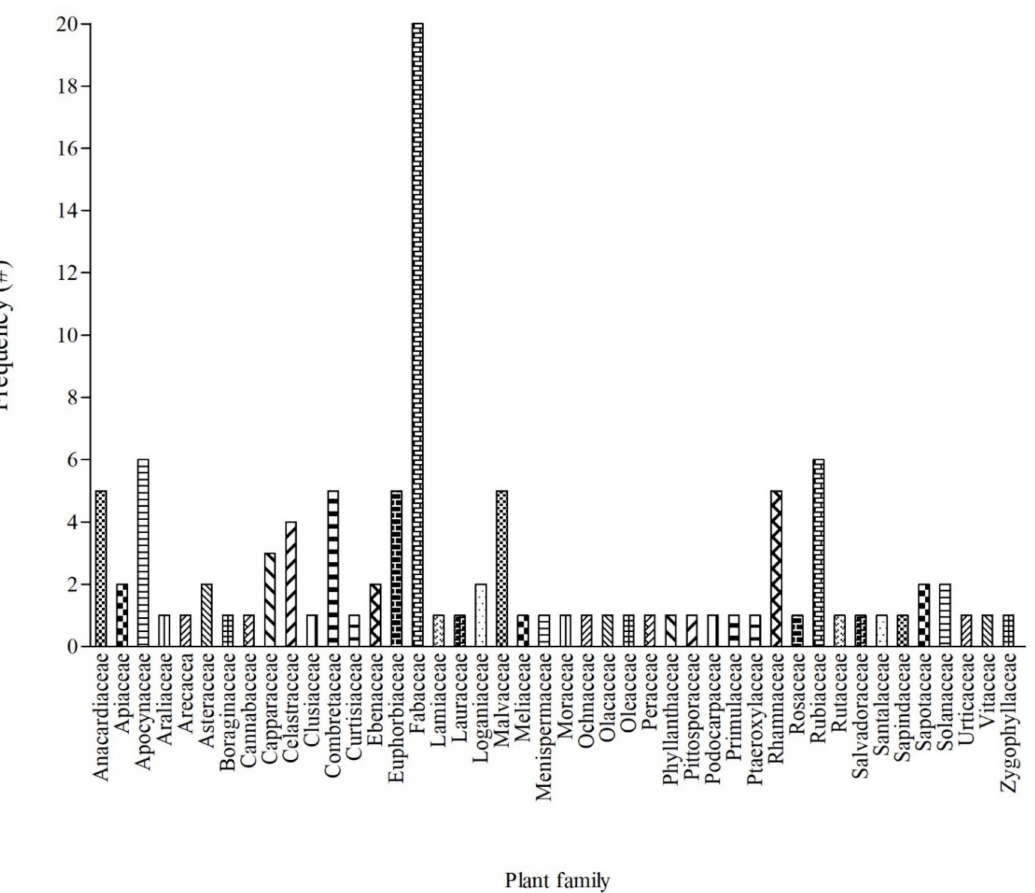
Figure 1. Frequency of the 44 families of woody plants used in South African ethnoveterinary medicine. # = number of